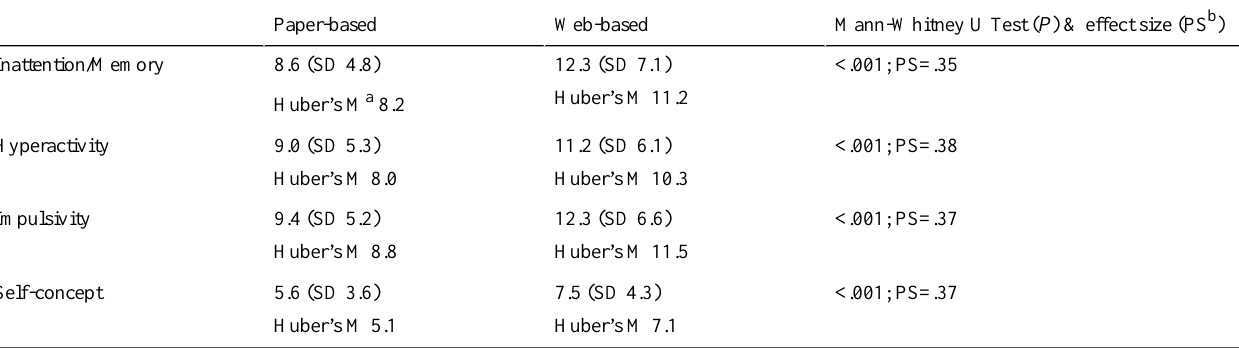
Table 4. Means, standard deviations, and Huber’s M estimators of the CAARS subscales in the paper-based and Web-based samples with their respective P and effect size